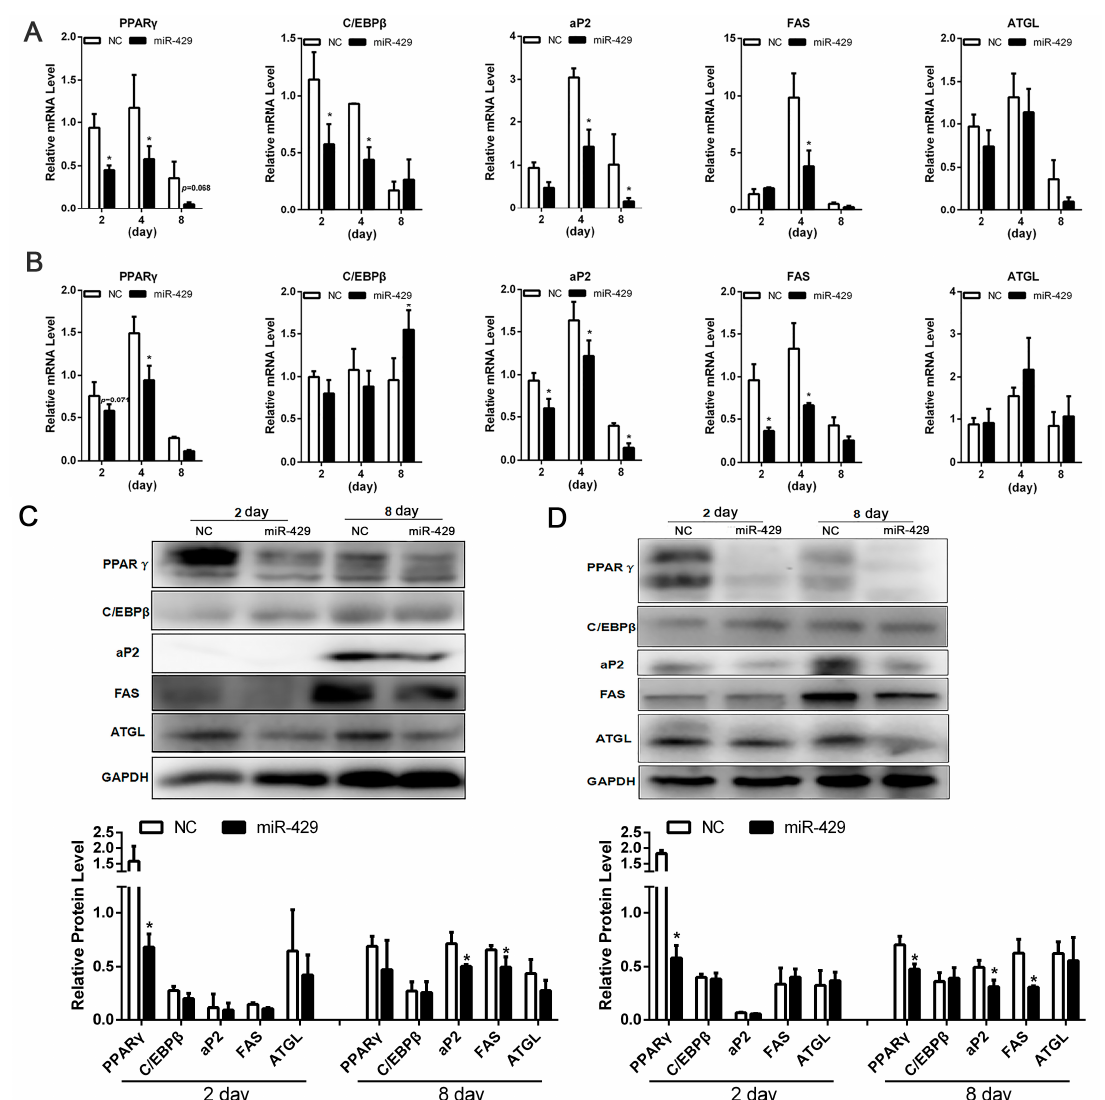
Figure 3. Overexpression of miR-429 inhibit PSPAs and PIPAs differentiation. mRNA expression of PPAR γ , aP2, C/EBP β , FAS , ATGL were determined on day 2, 4 and 8 of differentiation. ( A ) was detected in PSPAs ; ( B ) was detected in PIPAs . Relative protein level of PPAR γ , aP2, FAS, ATGL were detected on day 2 and 8 of differentiation; ( C ) Represented PSPAs ; ( D ) Represented PIPAs . Results are indicated as means ± SEM; n = 3; * p < 0.05.